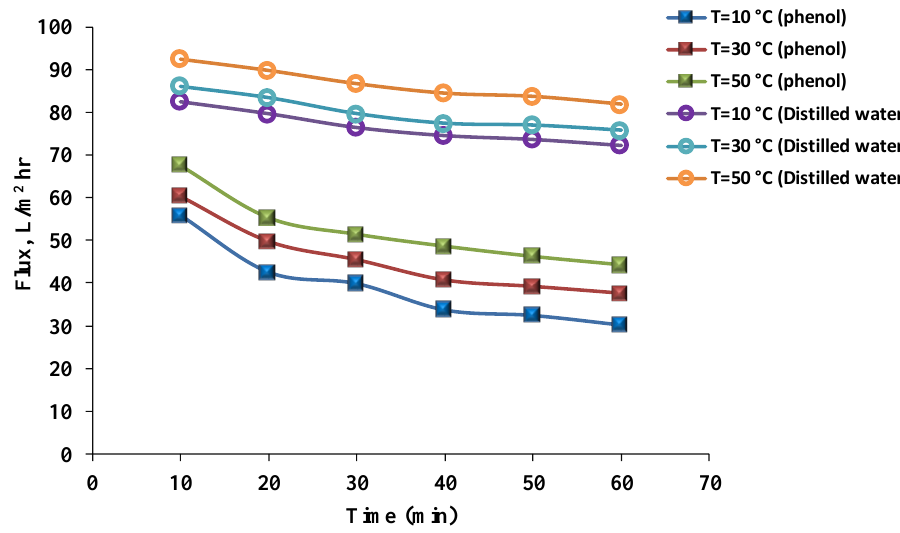
Figure 10. Phenol solution and distilled water’s fluxes with time using a hydrophobic membrane at different temperatures (pressure = 1 bar, phenol concentration = 50 mg/L).